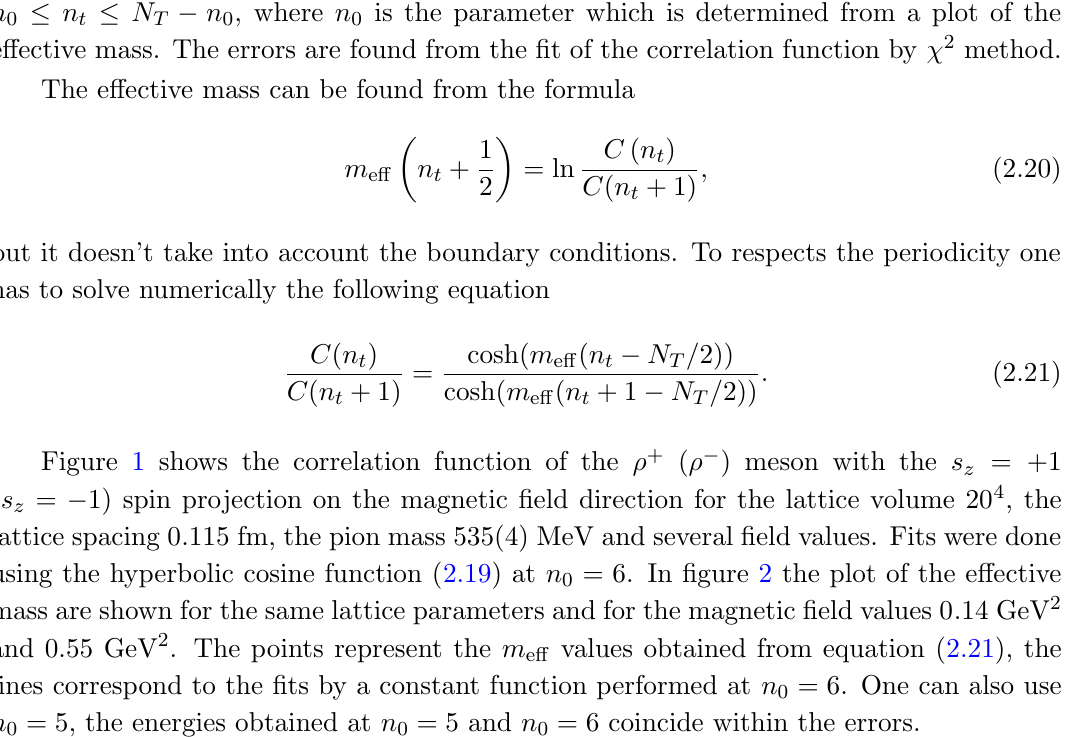
for the highest energy sublevel than for the lowest